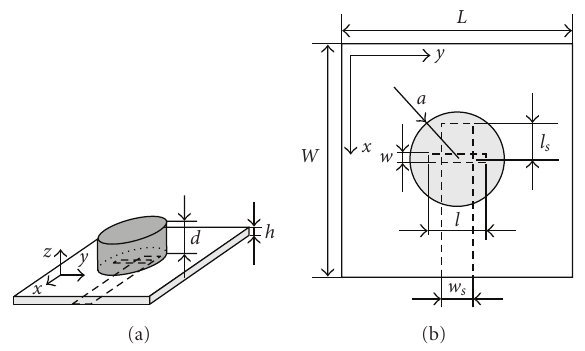
Figure 4: Return loss numerically computed for the CDRA setup of Figure 2. Good matching at the fundamental frequency is evident, while mismatch at first and second higher-order harmonics is insu ffi